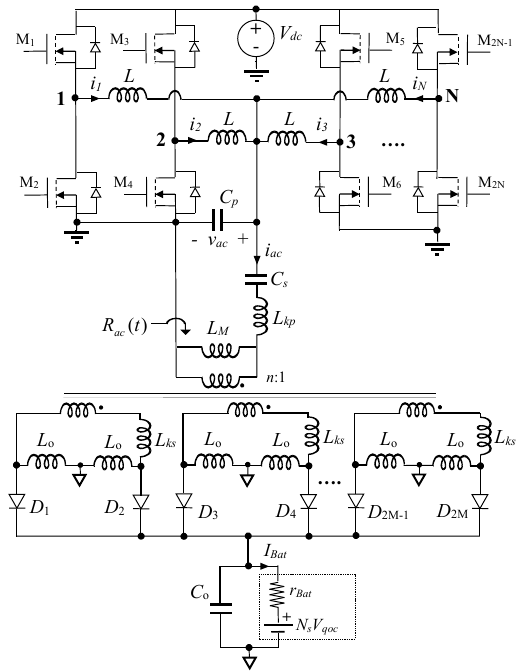
Figure 5. General architecture of the battery charger based on an N -phase LC p C s resonant inverter with an M -winding current-doubler rectifier as output stage. Multiple configurations are possible according to the N and M values.